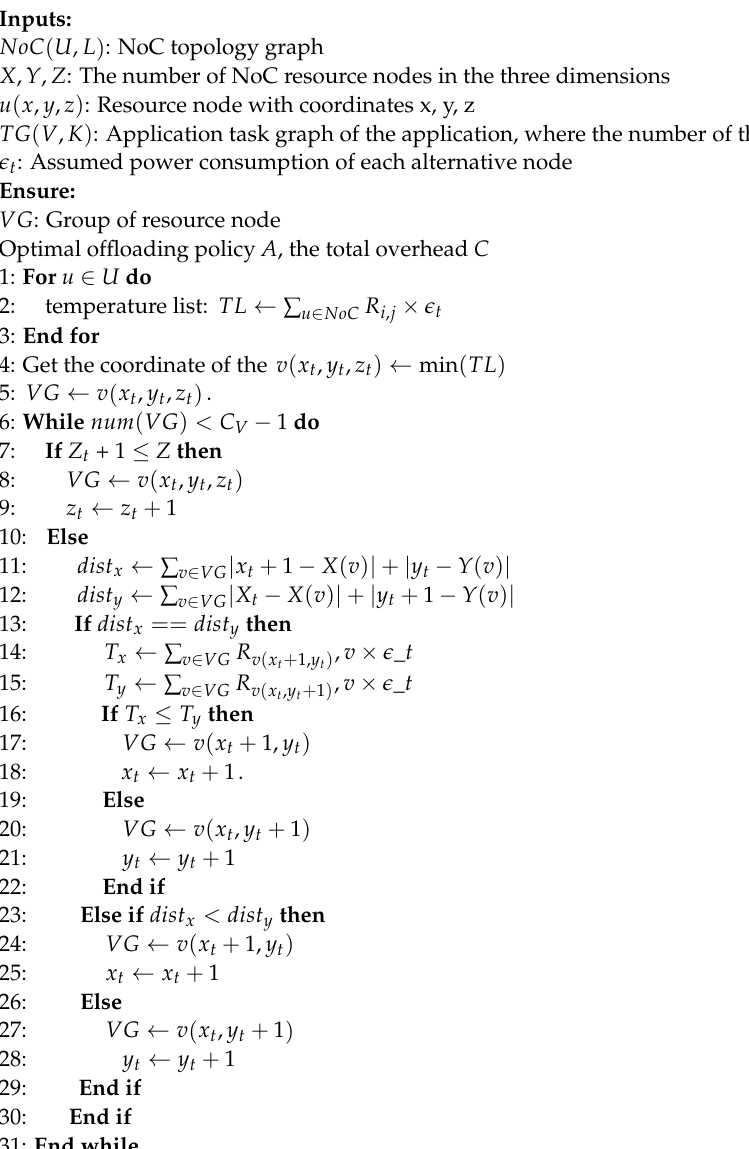
Algorithm 1 : NoC Regional Division